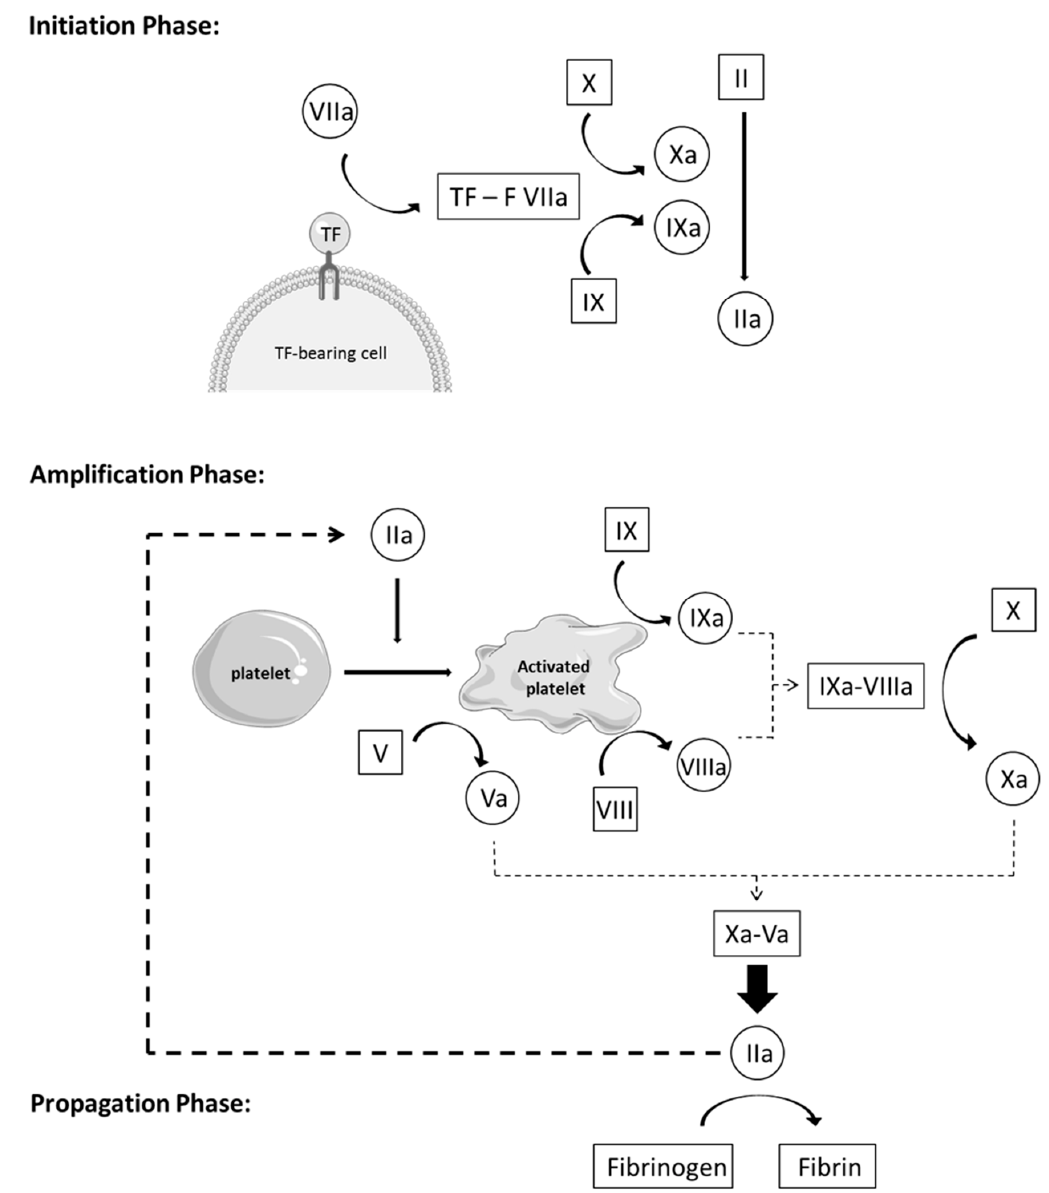
Figure 1. Activation of the coagulation can be described in three phases: During the initiation phase, small amounts of thrombin (IIa) are generated, inducing an important amplification loop through activation of platelets and cofactors V and VIII during the amplification phase. A large amount of thrombin (IIa) is thus generated, leading to an efficient burst of all enzymatic reactions involved in the entire coagulation process. In turn, during the propagation phase, these vast amounts of thrombin (IIa) lead to large quantities of fibrin strains, the final product of coagulation, consolidating the blood